Question: In one sentence, what is this figure communicating?
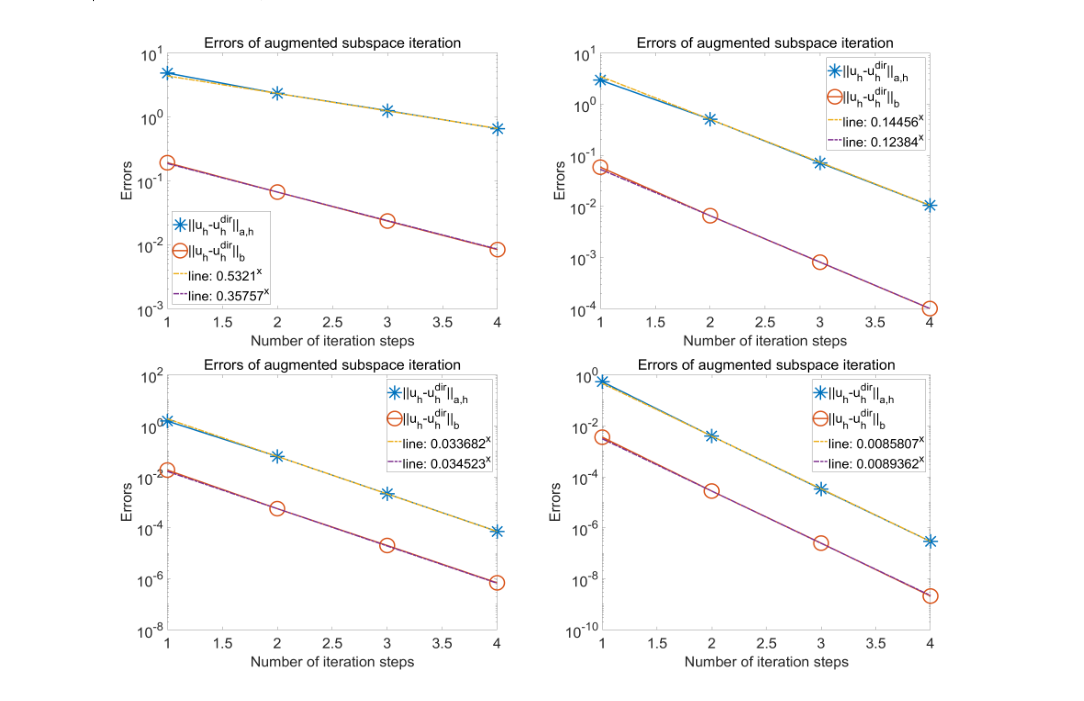
Answer: The convergence behaviors for the only 4-th eigenfunction by Algorithm 2 with the coarse space being the linear finite element space on the mesh with size H = √